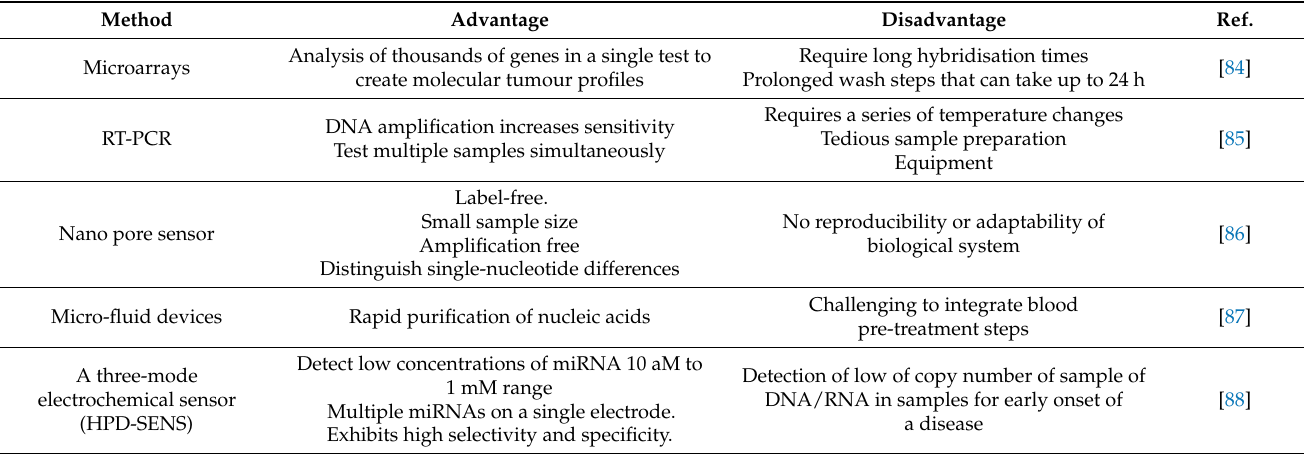
Table 3. Clinical and pre-clinical molecular methods for detection of nucleic